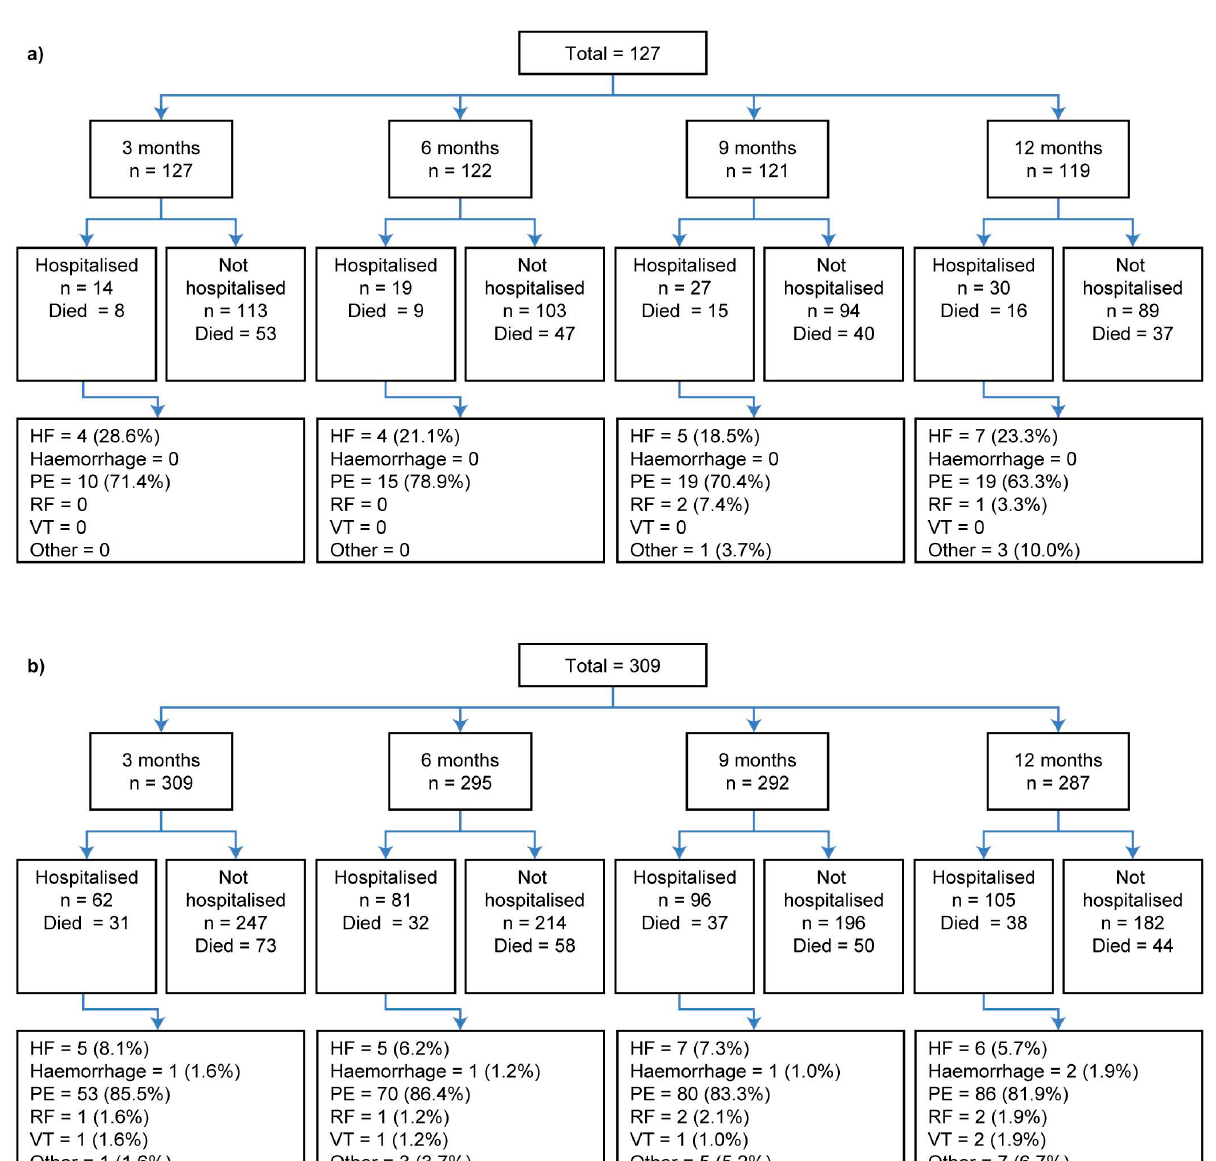
Figure 1. Landmark analysis patient disposition for ( a ) inoperable and ( b ) operable patients. The number of patients listed as “Died” in each group refers to the status at the data cut-off of 31 December 2018; all patients who did not die by this date were classified as “censored”. Percentages may not total to 100%, as the denominator is number of patients; however, patients may have had more than one hospitalisation. Reasons for hospitalisation are summarised in the final row. HF, heart failure; PE, pulmonary embolism; RF, respiratory failure; VT, venous